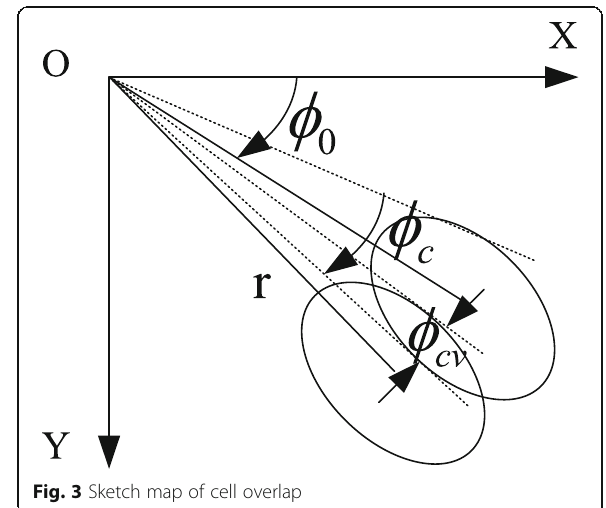
Fig. 3 Sketch map of cell